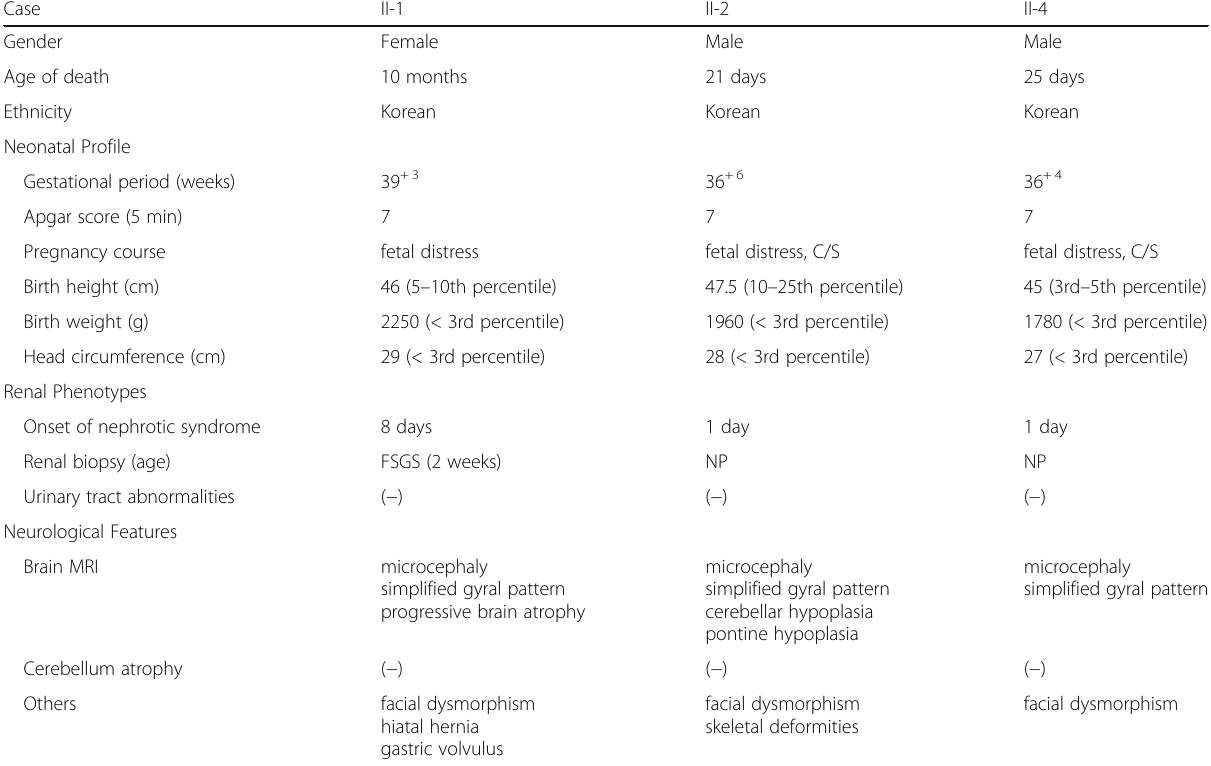
Table 1 Clinical features of affected individuals